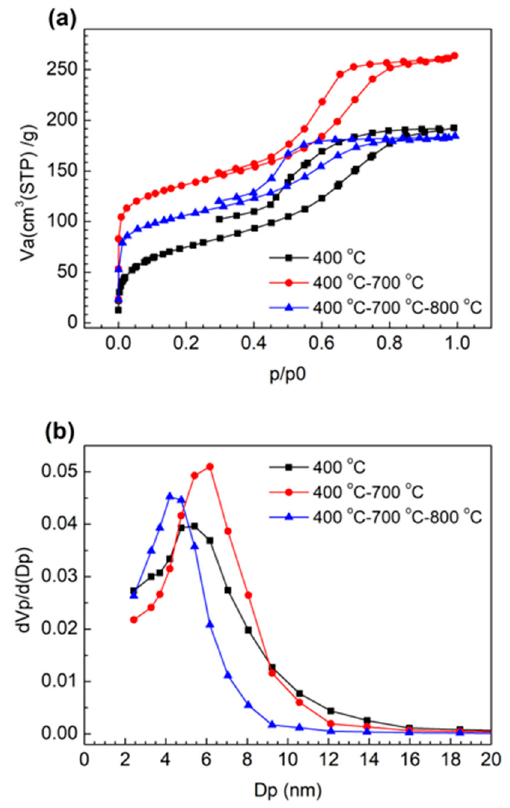
Figure 3. Nitrogen sorption isotherms ( a ) and the corresponding pore distributions ( b ) of MCF-A treated with different